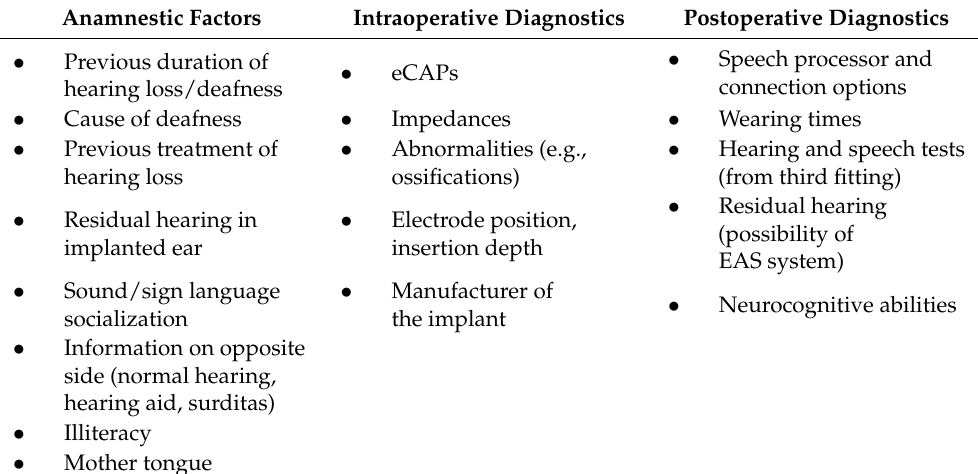
Table 1. Factors influencing the starting